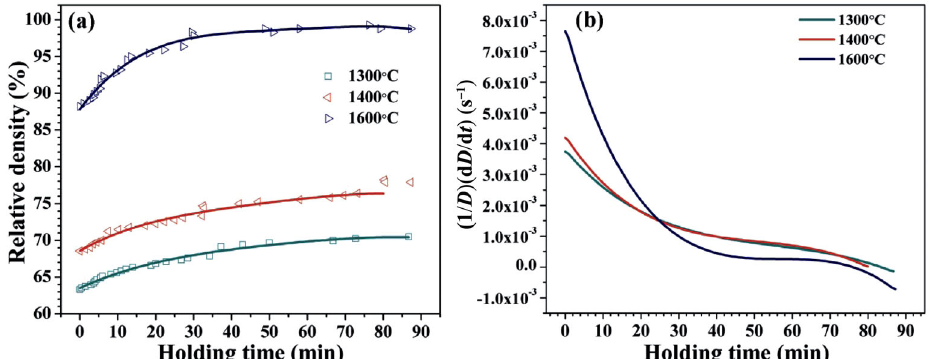
Fig. 6 (a) Densification and (b) densification rate curves of 1-ZrB 2 –SiBCN–ZrO 2 samples obtained at different temperatures with a holding time of 90